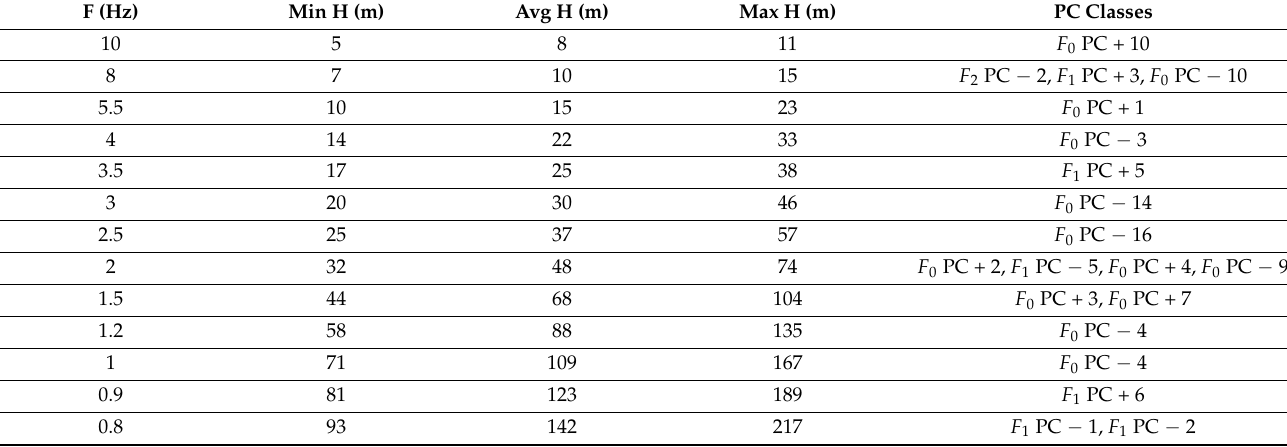
Figure 9. Borehole V S ( h ) profiles (light grey curves) and the average (continuous red curve), lower (dashed red curve) and upper (dashed-dotted curve) power laws estimated to assess the depth variability of the identified resonant interfaces. Finally, following Equation (3), for each resonance frequency value detected for each characteristic HVSR pattern, it was possible to compute a minimum, maximum and aver- age depth of the resonant interfaces characterizing the whole study area (Table 4). Table 4. Minimum (Min H), average (Avg H) and maximum (Max H) depth of the resonant interfaces responsible for the resonance frequencies (F) detected by the respective patterns of each PC class. Depth values are computed considering Equation (3) and, in particular, minimum, average and maximum depths are estimated using lower, average and upper power laws, respectively (Figure